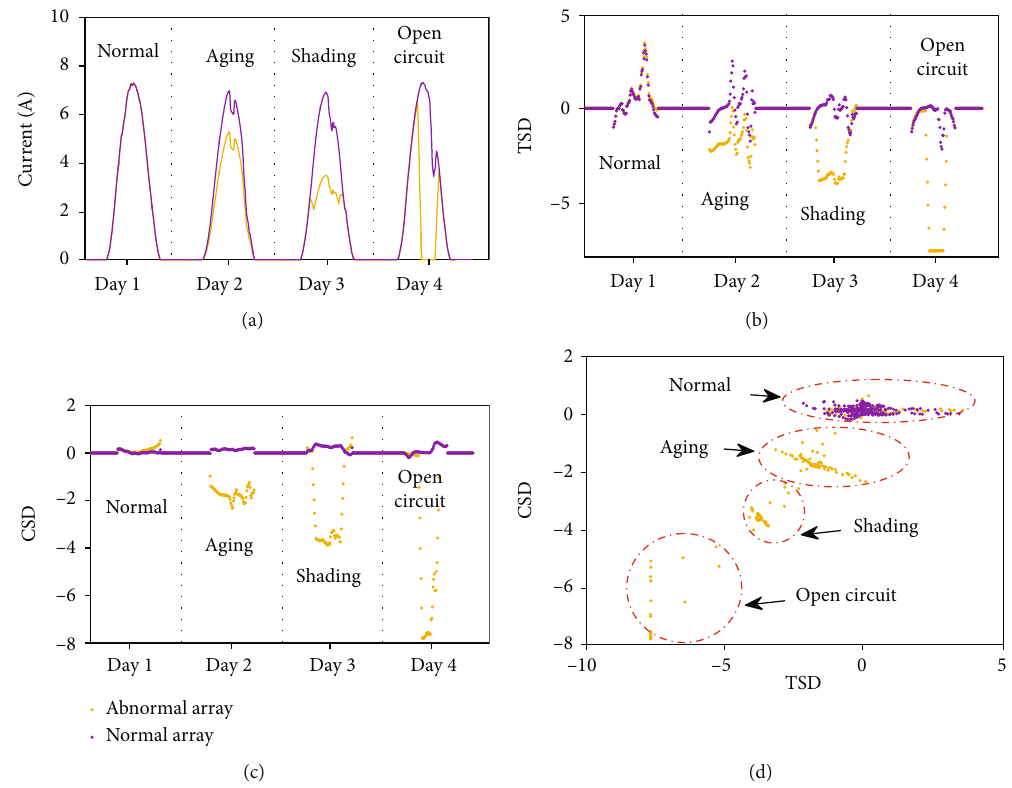
Figure 7: Output and corresponding TSD/CSD of the array current under di ff erent faults. (a) The deviation between the experimental array and normal array. (b) The TSD distribution under di ff erent faults. (c) The CSD distribution under di ff erent faults. (d) The deviation distribution under di ff erent faults.